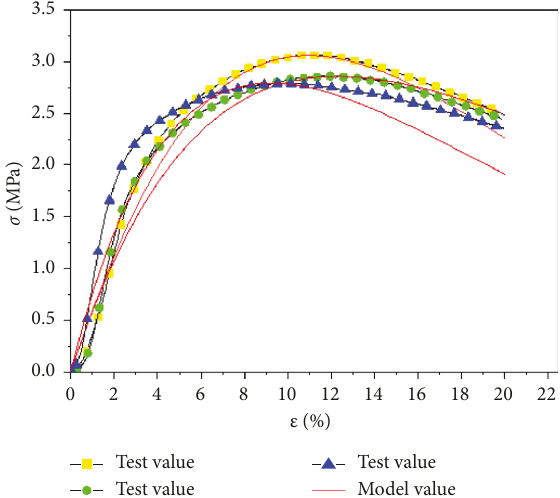
Figure 11: Comparison of model values and test values at − 10 ° C.